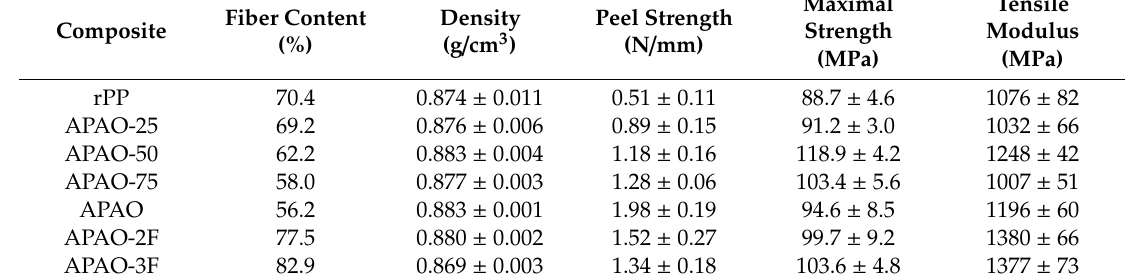
Table 3. Fiber content, density, peel strength and tensile properties of the composites.